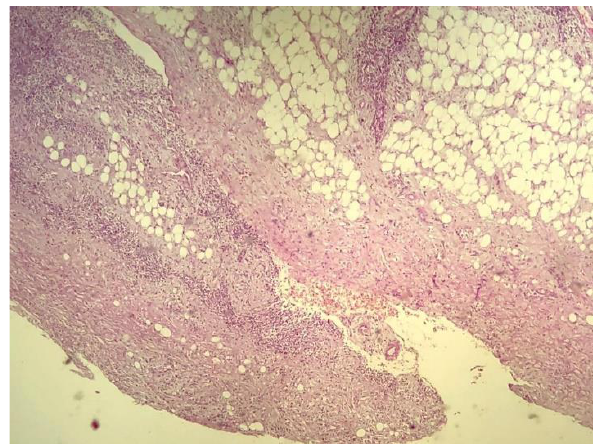
Figure 2. Thymic tissue, focally with cystic degeneration and mixed inflammatory